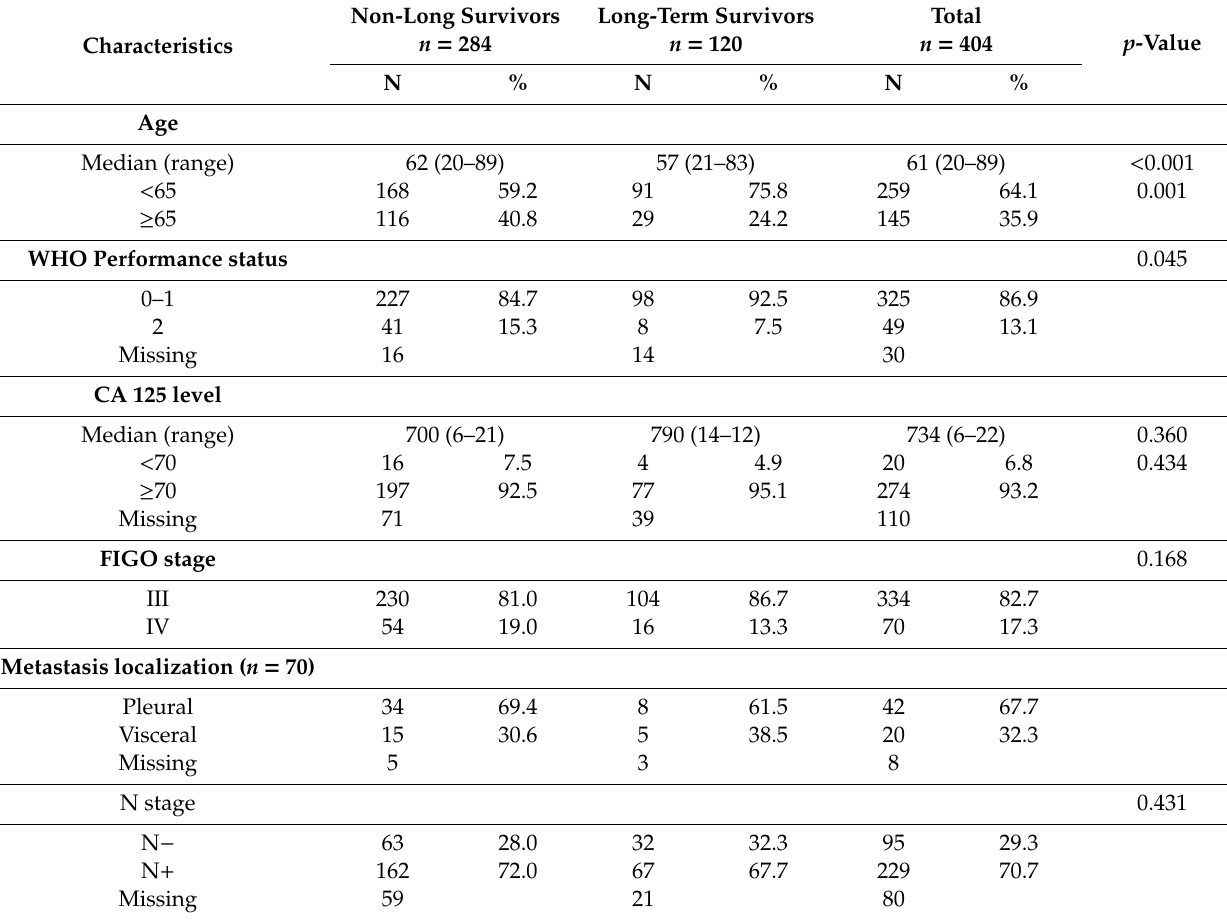
Table 1. Patients (cid:48) characteristics at